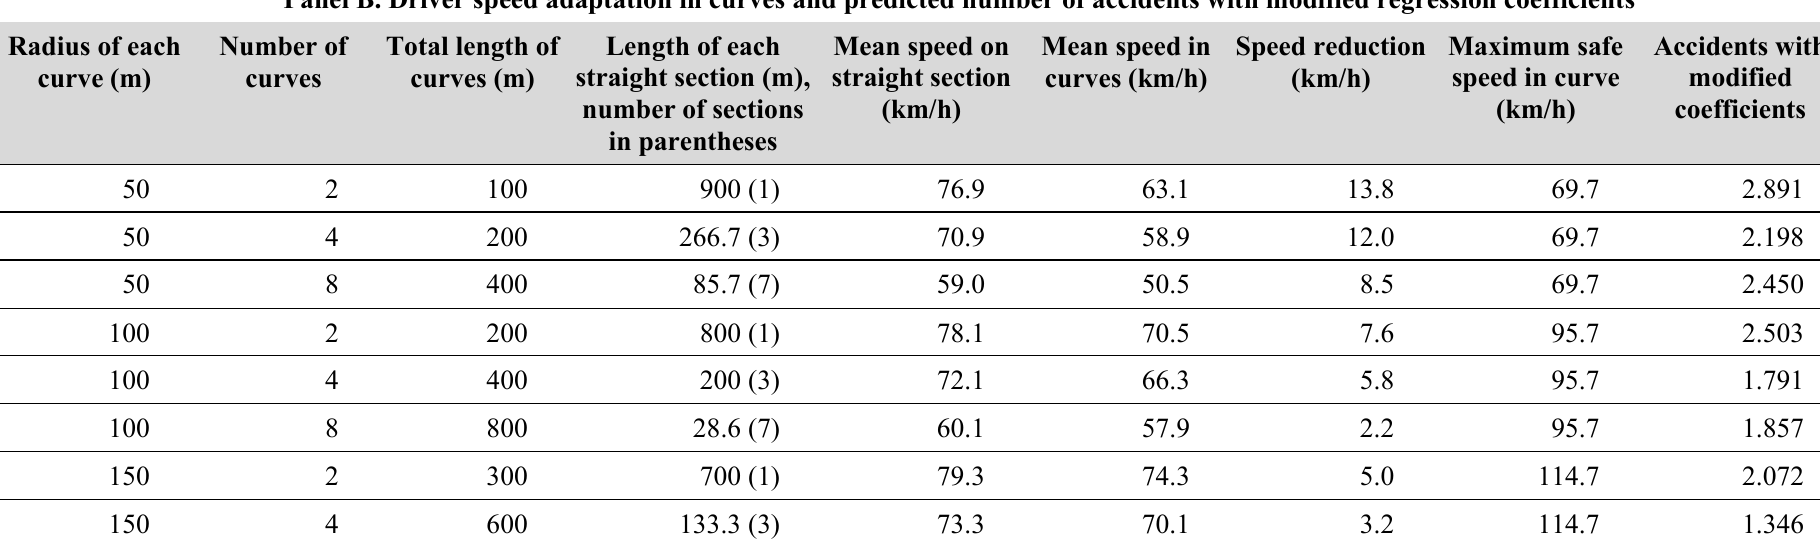
Panel B. Driver speed adaptation in curves and predicted number of accidents with modified regression coefficients Radius of each Number of Total length of Length of each straight section curve (m) curves curves (m)